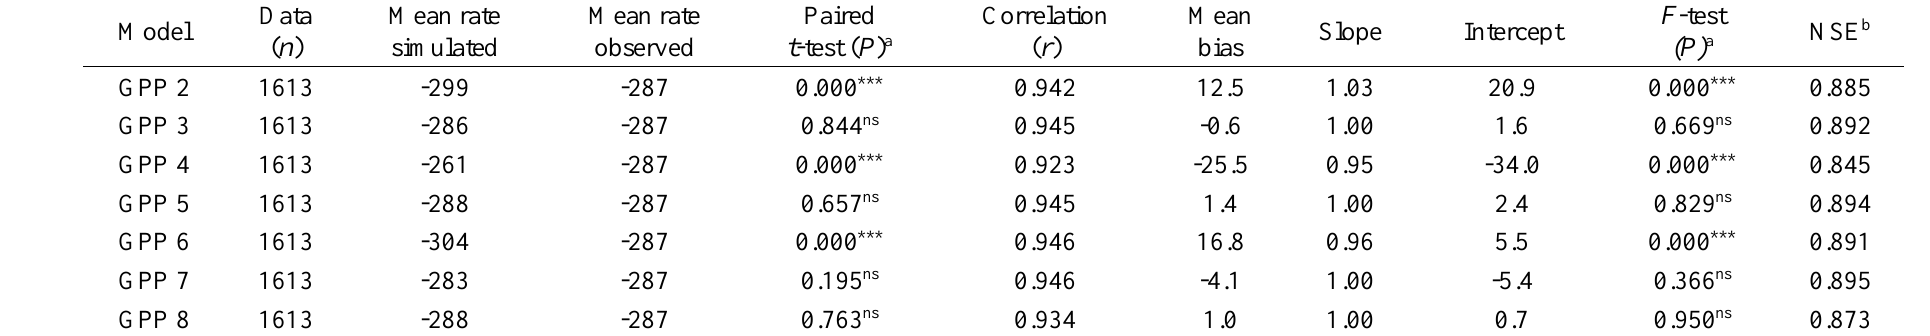
Table A4. Model performance statistics for gross primary production (GPP) models fitted to data from flooded (F) treatments.